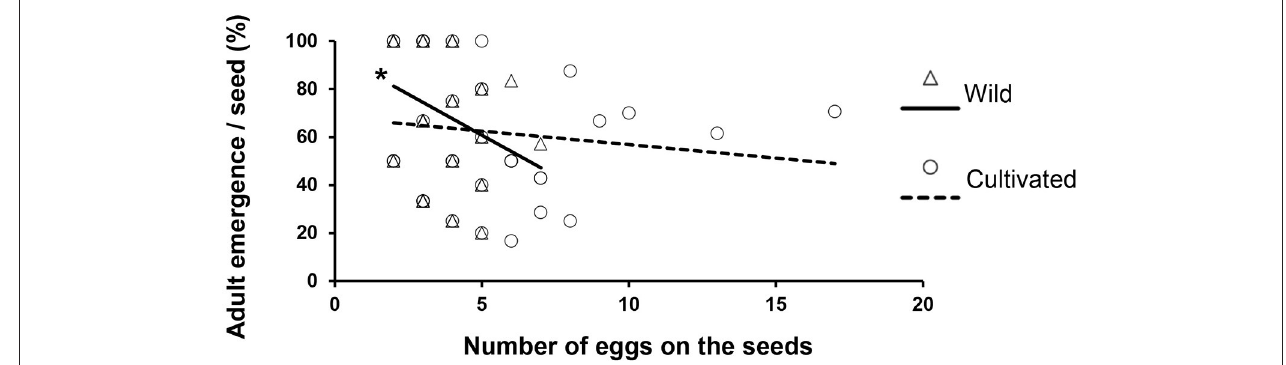
FIGURE 4 | Percentage of adults that emerged from each seed calculated as, number of adults that emerged from the seed/number of eggs laid on the seed * 100. Dashed line indicates linear regression for beetles that developed in cultivated seeds ( N = 43, Spearman r = − 0.21, P = 0.17) and solid line shows linear regression for beetles that developed in wild seeds ( N = 51, Spearman r = − 0.32, P = 0.023).